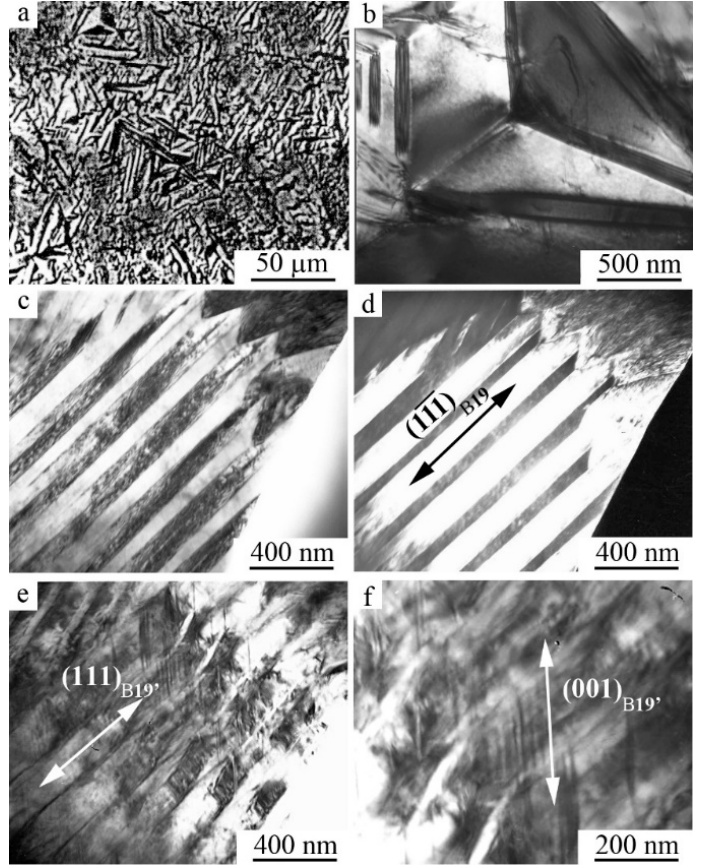
Figure 10. ( a ) SEM and ( b – f ) TEM microstructure images of Ti 50 Ni 40 Cu 10 alloy obtained ( a – d ) at room temperature and ( e , f ) at 120 K.